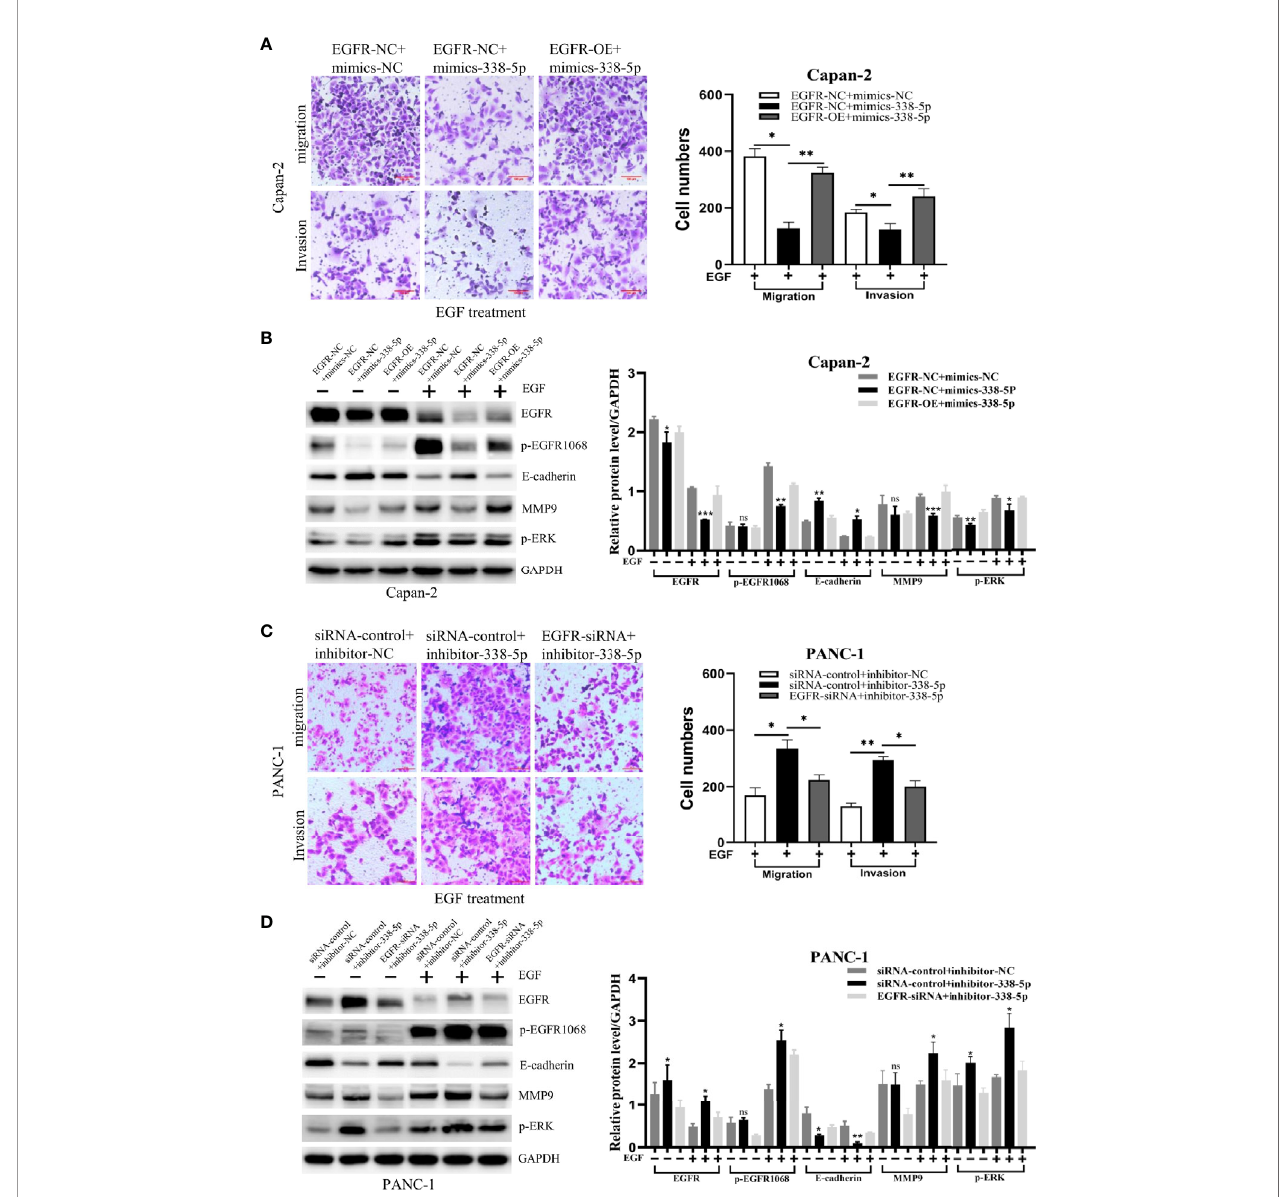
FIGURE 5 | EGFR mediates the effects of miR-338-5p on pancreatic cancer cells. (A, B) EGFR overexpression weakened migration, invasion (A) and the related protein levels (B) , in miR-338-5p overexpressing Capan-2 cells after 50 ng/ml EGF treatment for 48 h. (C, D) EGFR silencing reversed migration, invasion (C) and the related protein levels (D) in miR-338-5p silencing PANC-1 cells after 50 ng/ml EGF treatment for 48 h. *P < 0.05; **P < 0.01; ***P <